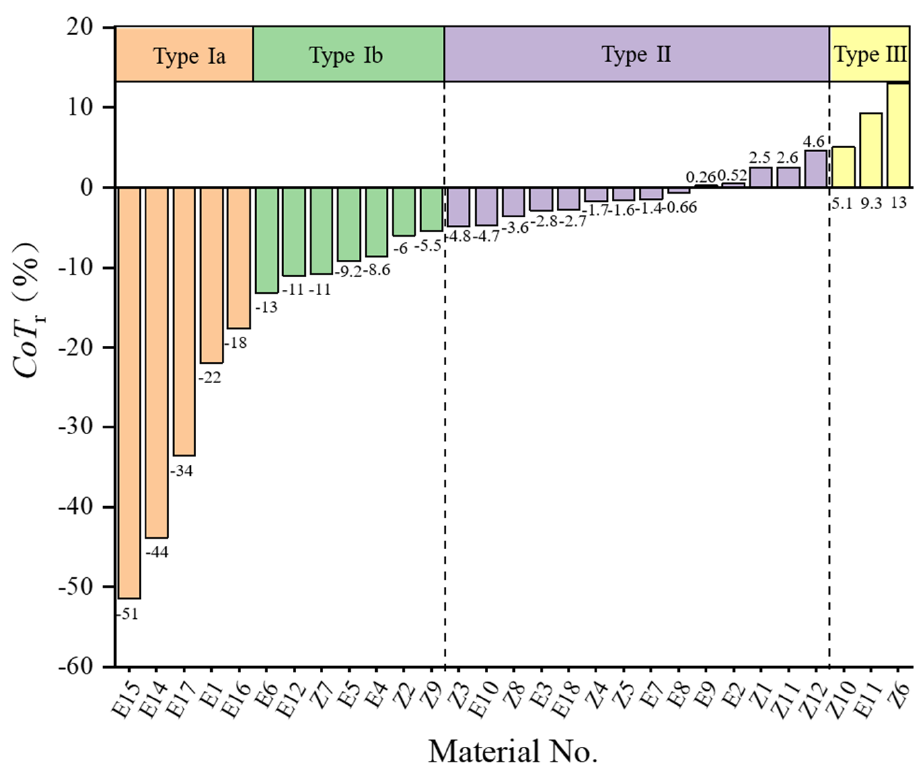
Figure 7. The tabletability change classification system (TCCS) and the CoT r values for 29 materials.